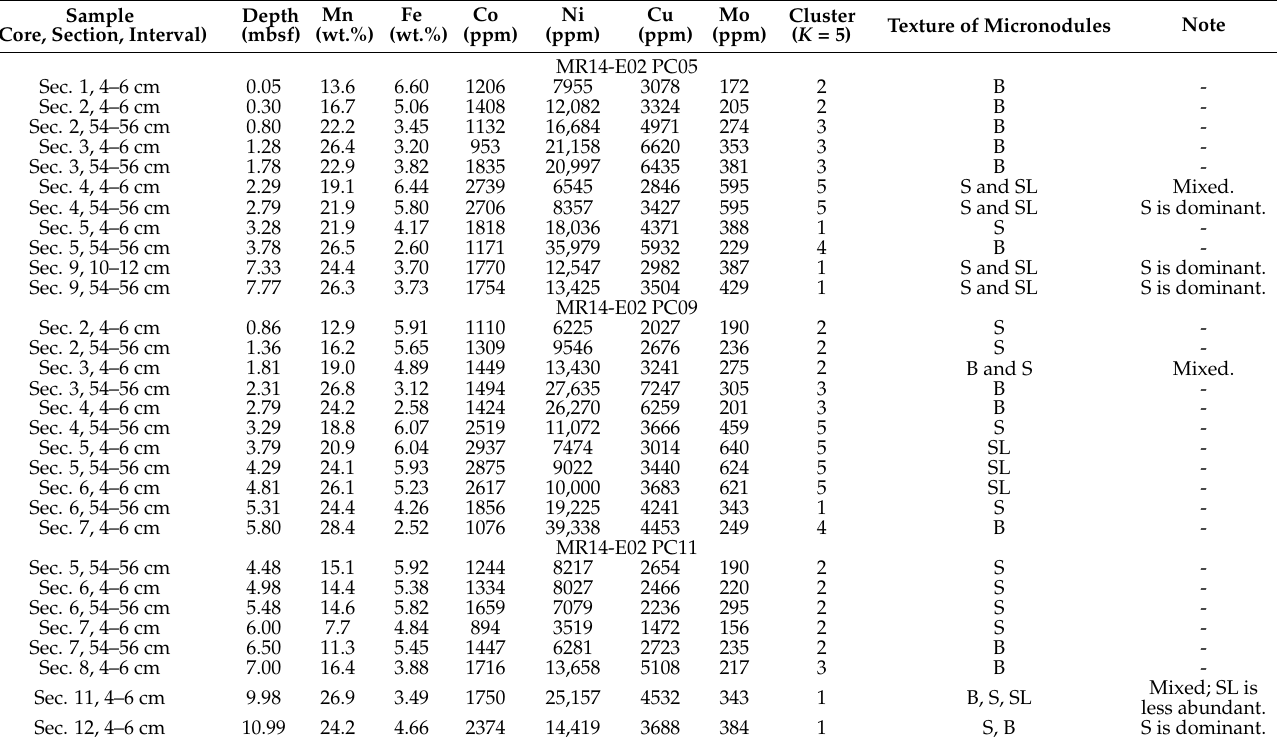
Table 1. Element contents used for the cluster analysis, clustering results, and surface textures of the Fe–Mn micronodules. Sample (Core, Section,